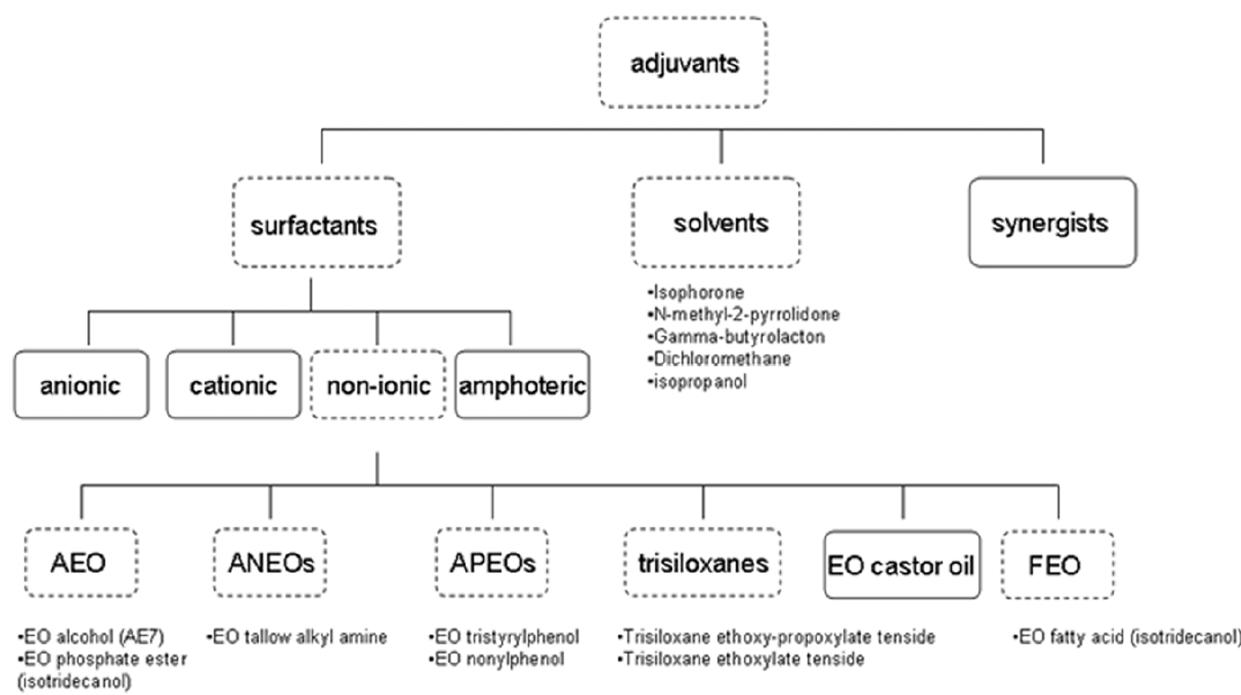
Figure 1. Overview of major types of adjuvants. Dotted squares represent selected groups, below one or more evaluated representatives. APEOs: alkyl phenol ethoxylates, ANEOs: alkyl amine ethoxylates, AEO: alcohol ethoxylates, FEO: fatty acid ethoxylates and EO: ethoxylated.